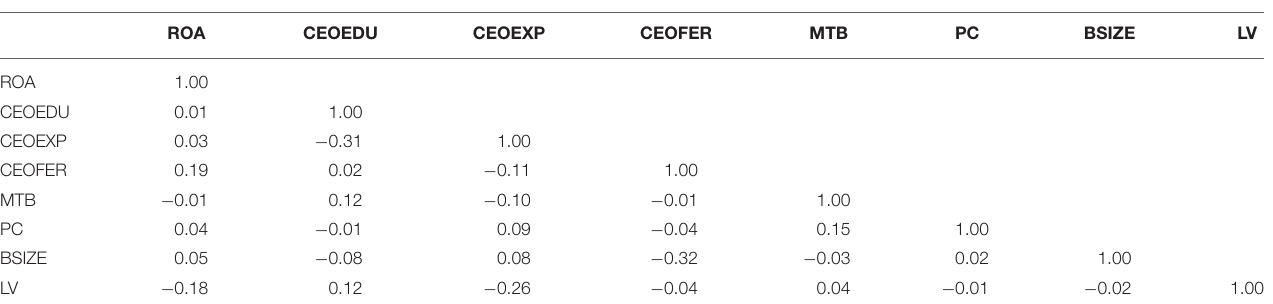
TABLE 3 | Correlation